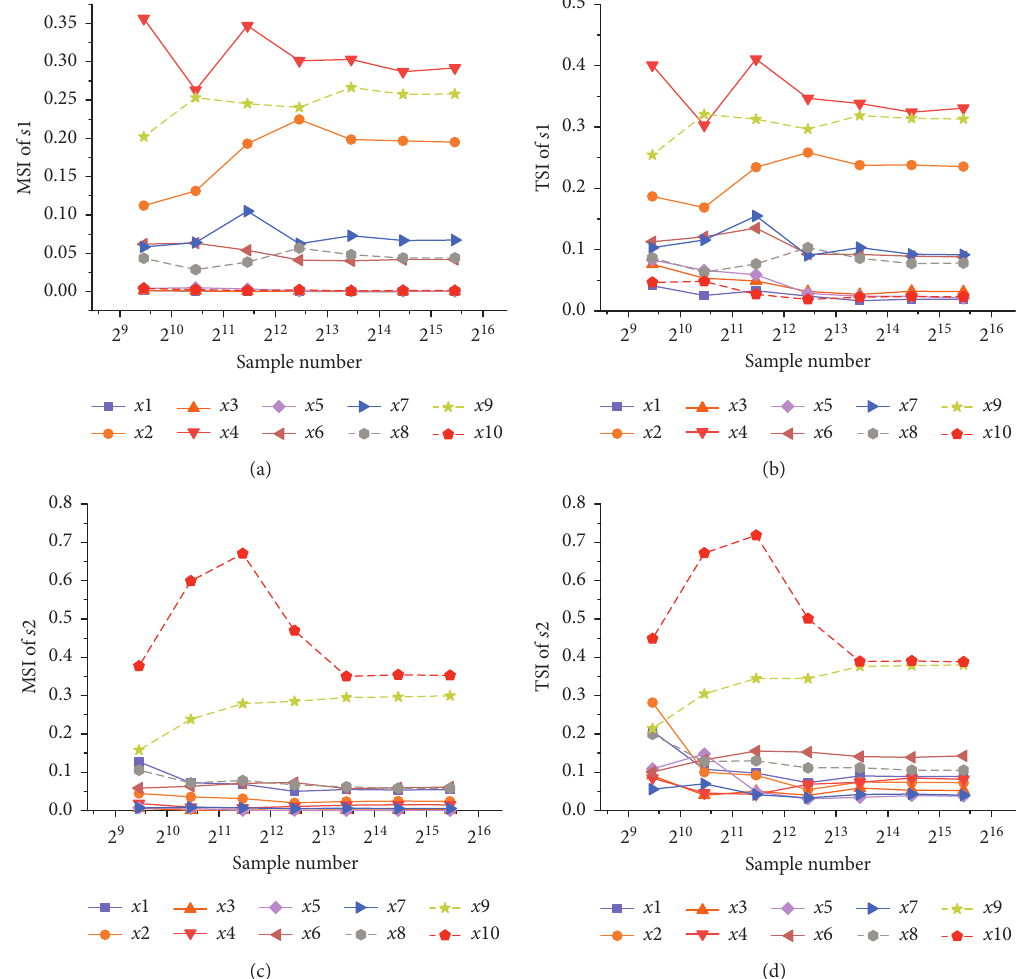
Figure 5: Parameter sensitivity rankings of the eFAST method for (a) MSI of s 1, (b) TSI of s 1, (c) MSI of s 2, and (d) TSI of s